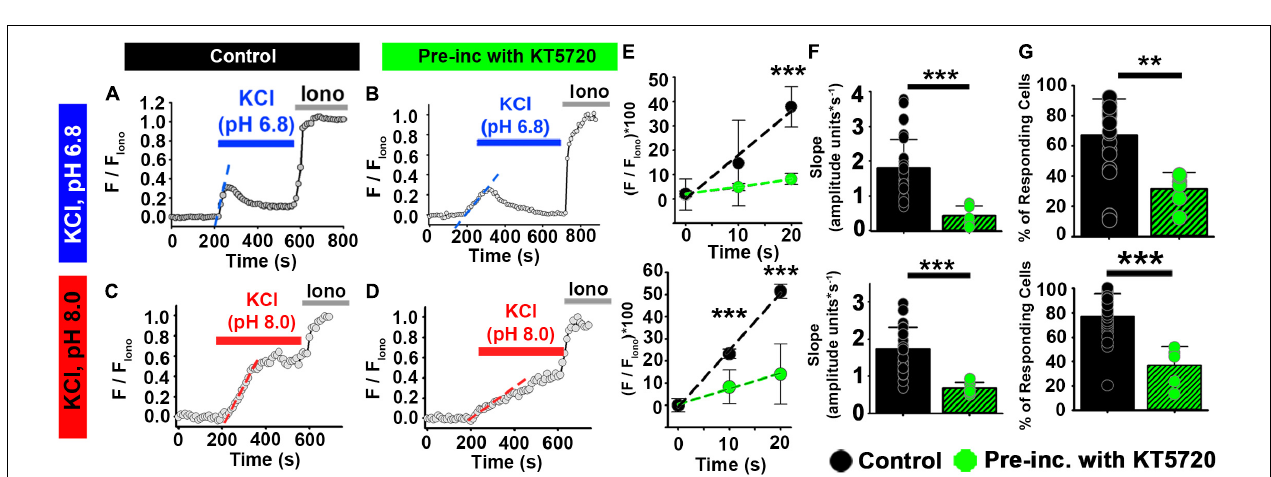
FIGURE 6 | PKA inhibitor KT5720 impairs the effect of HCO 3 − on depolarization-evoked Ca 2 + responses in ejaculated human sperm. (A–D) Representative traces of [Ca 2 + ] i responses to 50 mM KCl at (A,B) pH 6.8 and (C,D) pH 8.0 in ejaculated human sperm in non-capacitating conditions in (A,C) control and (B,D) after pre-incubation with KT5720. (E) Linear fit of the averaged normalized fluorescence in the first 20 s after KCl addition. (F) Graph of slope values of the best-fit regression line for each condition. Mean values at pH 6.8 were as follows: control, 1.80 ± 0.82 amplitude units * s − 1 (26 samples, 1836 sperm); and KT5720 pre-incubation, 0.426 ± 0.277 amplitude units *s − 1 (6 samples, 624 sperm). Mean values at pH 8.0 were as follows: control, 1.73 ± 0.594 amplitude units * s − 1 (26 samples, 3036 sperm); and KT5720 pre-incubation, 0.678 ± 0.162 amplitude units *s − 1 (5 samples, 974 sperm). (G) Graph of the percentage of responsive sperm. Mean values at pH 6.8 were as follows: control, 66.94% ± 24.30 (26 samples, 1836 sperm); and KT5720 pre-incubation, 31.57% ± 10.87 (6 samples, 624 sperm). Mean values at pH 8.6 were as follows: control, 77.04% ± 18.67 (26 samples, 3036 sperm); and KT5720 pre-incubation, 36.90% ± - 15.33 (6 samples, 974 sperm). ** P < 0.010, *** P < 0.001 by independent t -test. Error bars indicate standard deviation. Iono = 5 µ M Ionomycin + 2 mM Ca 2 +